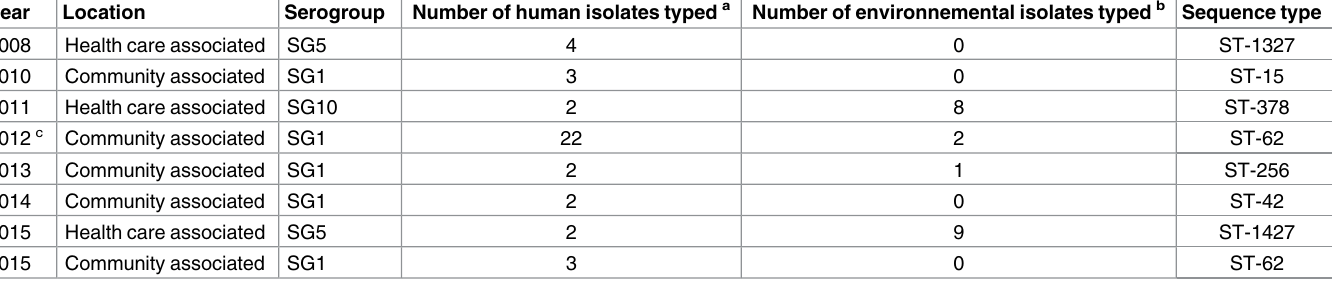
Fig 2. Sequence type (ST) distribution amongst legionellosis sporadic cases and their serogroup between 2005 and 2015 (n = 141). For ST-1327, 1 isolate has cross reaction with serogroup 5 and 9 antibodies. For ST-378, 1 isolate was from serogroup10 and 3 has an inconclusiveserogroup. doi:10.1371/journal.pone.0163818.g002 new combination of previously known alleles and the remaining were STs with one new allele. Amongst the 108 sporadic cases of SG1 typed by SBT, ST-62 was the most frequent (16.6%), followed by ST-213 (10.2%), ST-1 (8.3%) and ST-37 (8.3%). Amongst other serogroups, ST- 1327 (SG5) (27.3%) and ST-378 (SG10) (12.2%) were the most frequent. Table 1 shows STs for outbreak associated to human and environmental isolates. Amongst the 10 outbreaks investigated by the Quebec’s public health authorities from 2005 to 2015, iso- lates from 8 outbreaks were available for typing. A different ST was involved for each outbreak investigated, except for two outbreaks where ST-62 was involved. Notably, all the community associated outbreaks, potentially or confirmed to be associated with a cooling tower were caused by Lp 1 strains, by opposition to hospital associated outbreaks that were caused by ser- ogroups of Lp other than SG1. Table 2 shows the STs for the remaining environmental isolates where ST-1 represents the more frequent (26.5%). Table 1. Legionella pneumophila outbreaks investigated by LSPQ between 2005 and